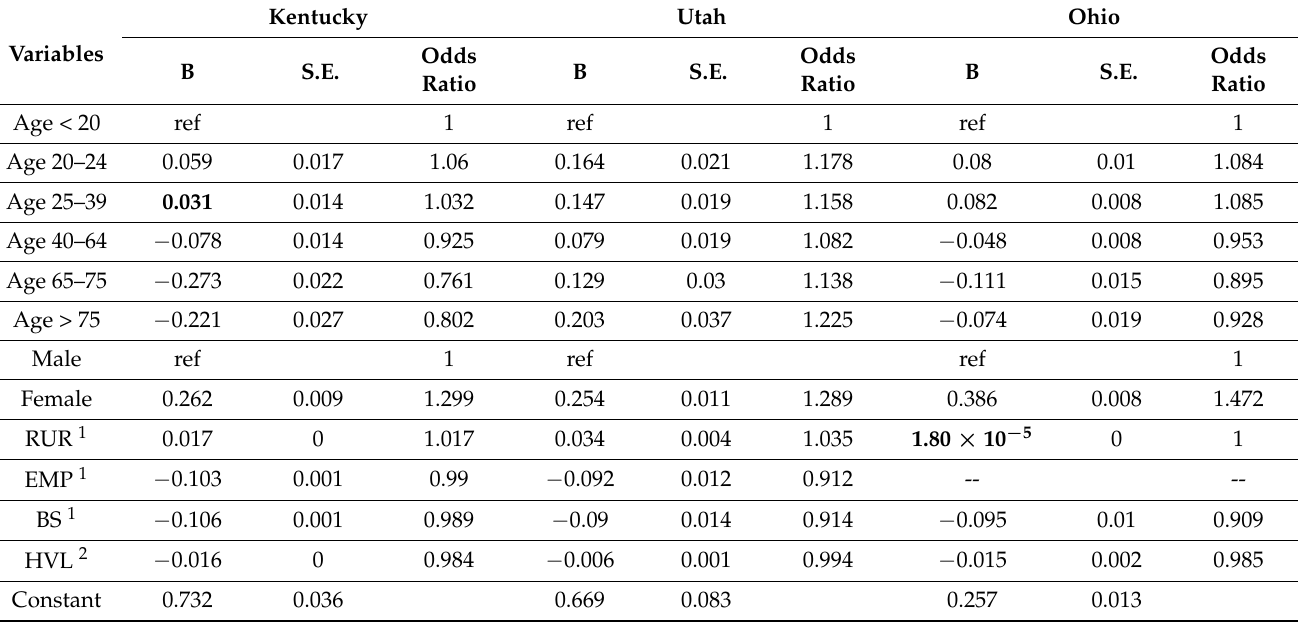
Table 2. Final model; Kentucky, Utah and Ohio.